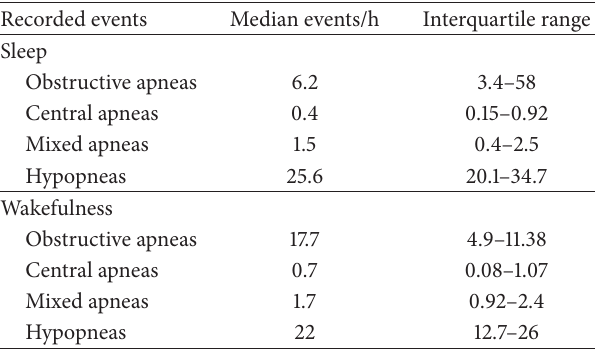
Table 4: Results of cardiorespiratory monitoring in patients with typical Rett syndrome ( 𝑛 = 228 ) confirming a high frequency of apneas and hypopneas either during wakefulness or sleep states.